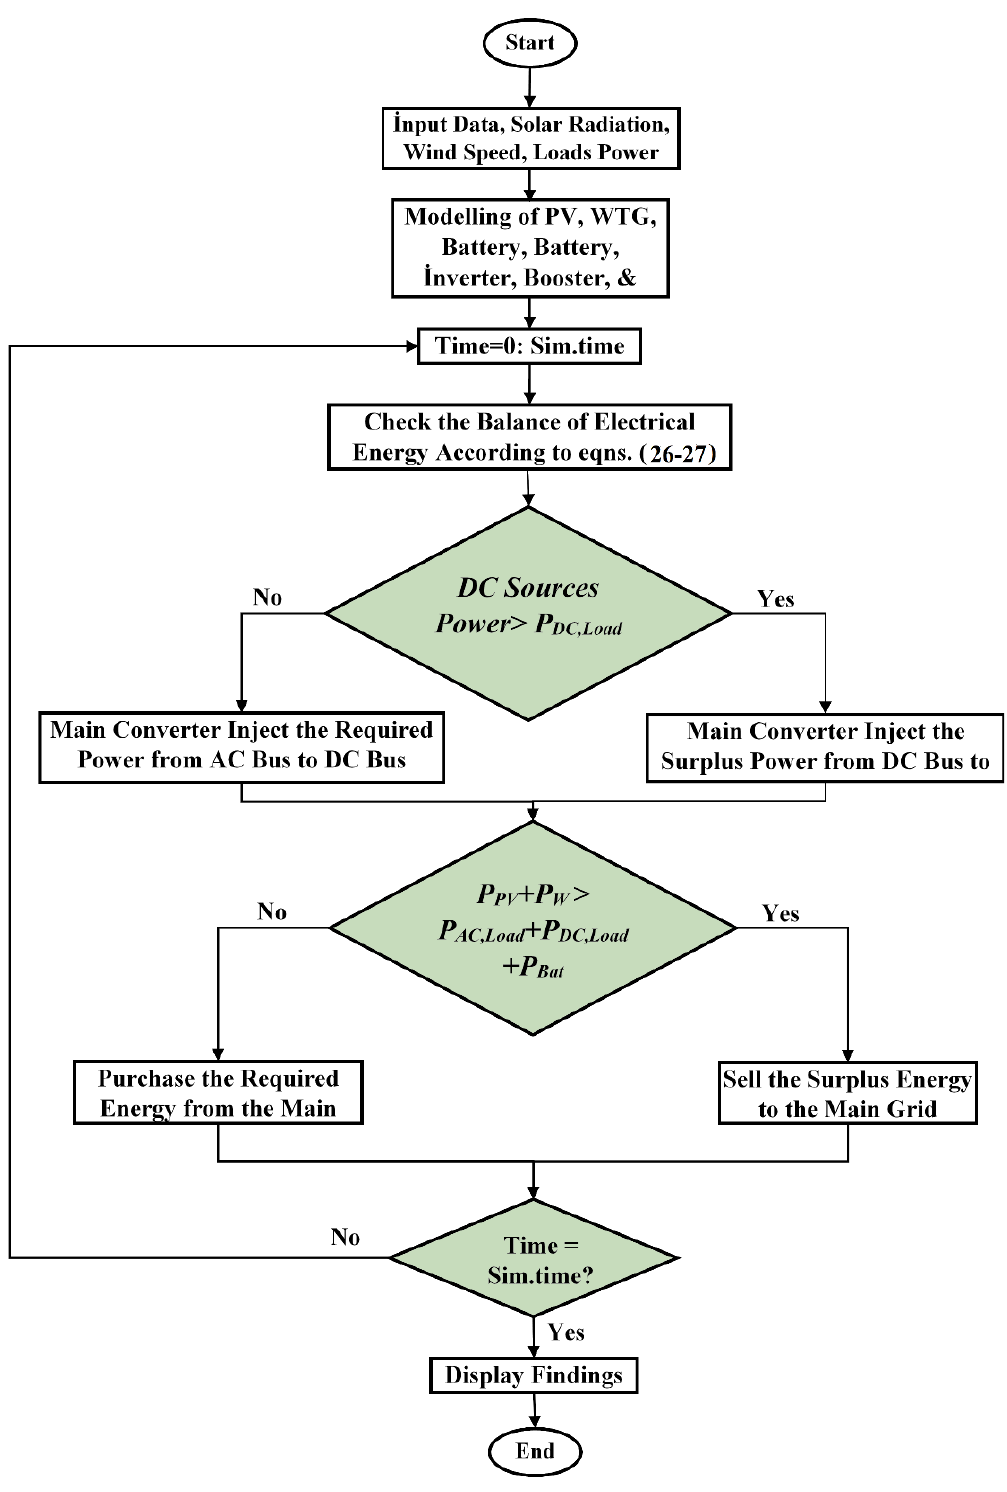
Figure 2. The proposed system’s operating strategy.